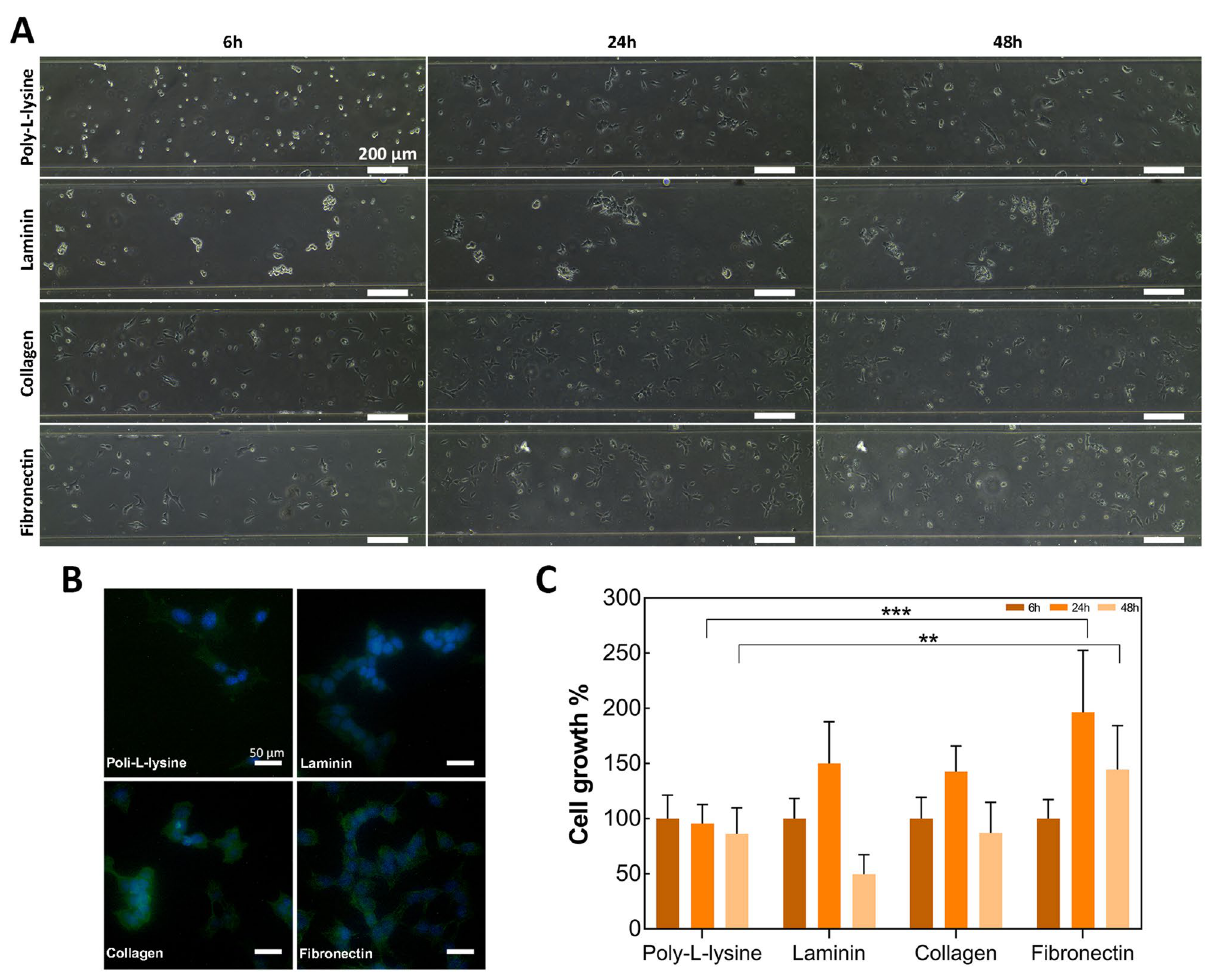
Figure 2. Cell behavior using different adhesion molecules. ( A ) Phase contrast microscope images of SH-SY5Y cells, grown on different substrates in microfluidic devices at 6, 24, and 48 h. Scale bar: 200 μm. ( B ) Fluorescent images of SH-SY5Y cells. DAPI and Phalloidin-FITC stained SH-SY5Y cells grown on different substrates in microfluidic devices at 48 h. Scale bar: 50 μm. ( C ) Bar graph representation of SH-SY5Y cell growth cultured on different substrates at 6, 24 and 48 h, following normalization to cell count measured at 6 h. Histogram bars represent the average of 3 experiments and error bars indicate the standard deviation (Two-way ANOVA test: ** p < 0.005; *** p <